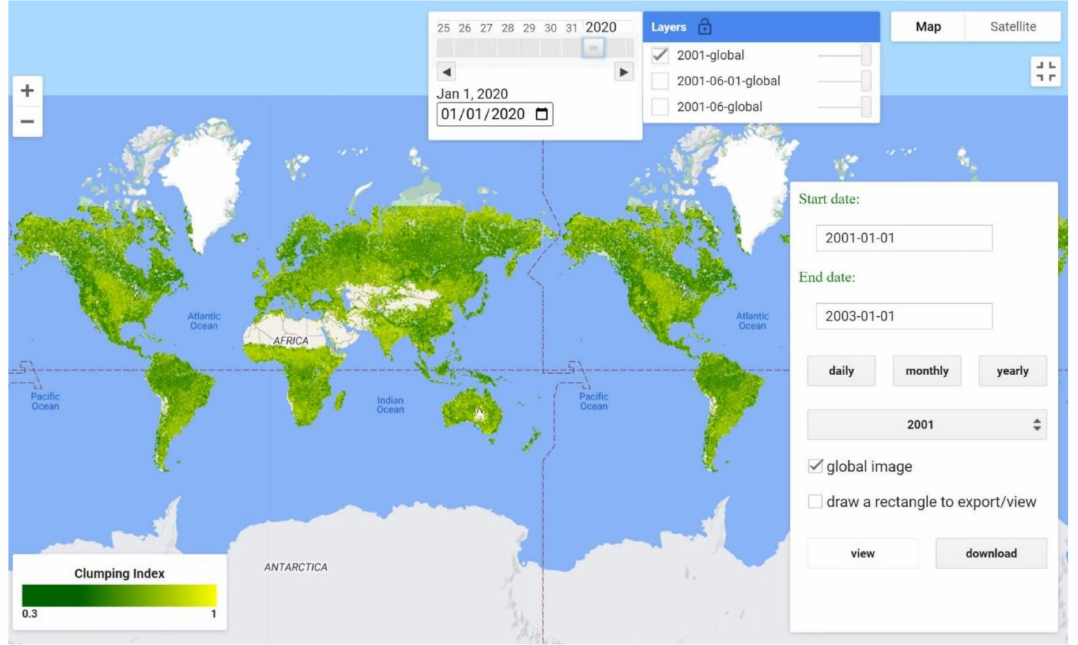
Figure 2. The graphic user interface for the CI retrieval and downloading tool. After the input of two dates, the corresponding selection appears. For detailed information on software usage, refer to https://github.com/CUGLiving/CAS-Clumping-Index-Products (accessed on 8 June 2022). After inputting the two dates (period) formatted as date strings, one of the buttons with text as daily, monthly, and yearly is clicked. The next screen will show the corresponding date list for selection. The daily CI image will be directly generated after smoothing. The monthly and yearly CI images are averaged from the daily smoothed CIs